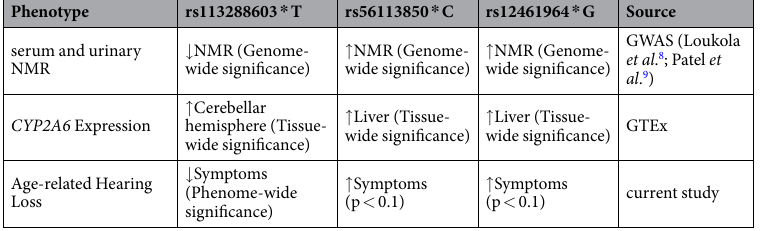
Table 2. Effect directions of the CYP2A6 allele associations with NMR, gene expression, and age-related hearing loss